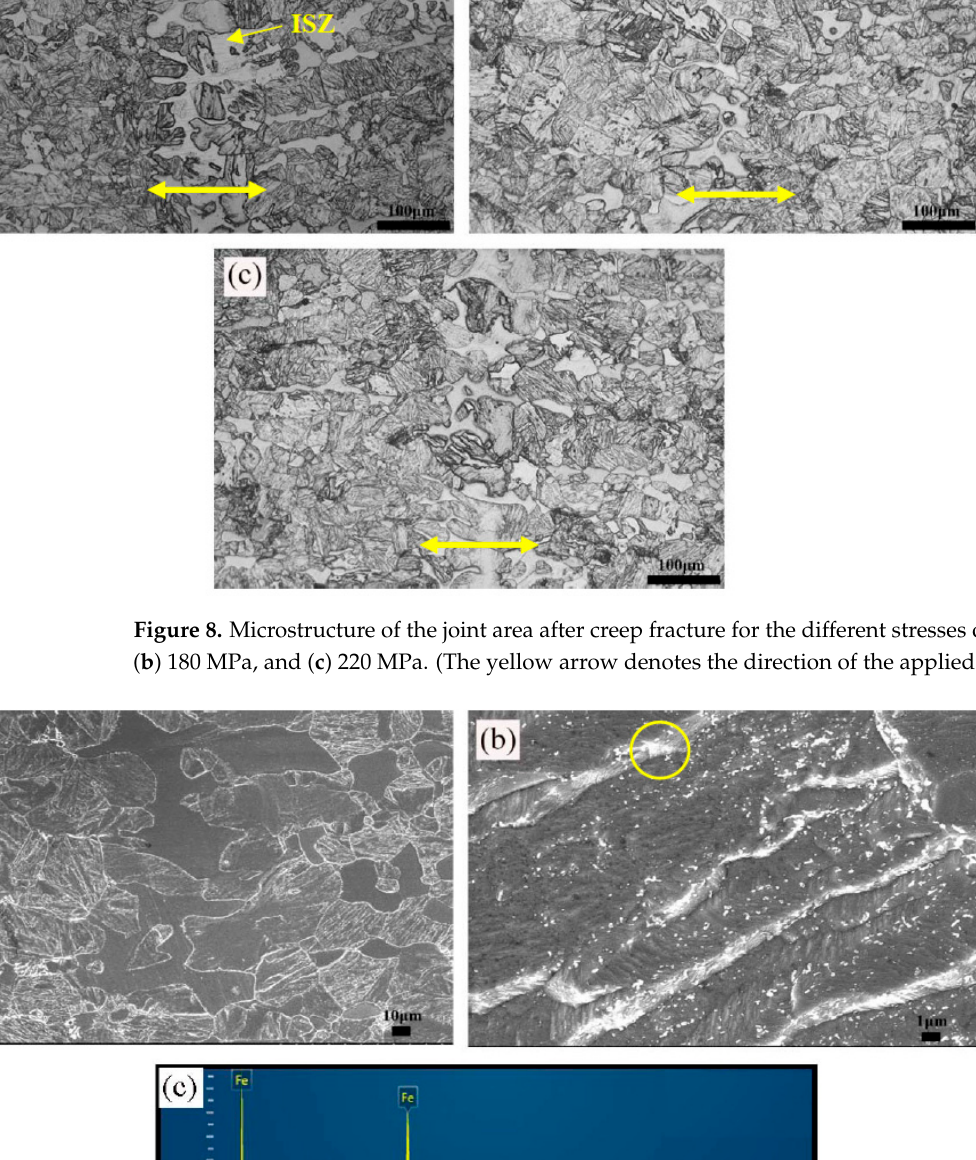
Figure 9. SEM images of the TLP joint after creep fracture under a stress of 220 MPa: ( a ) the low- magnification image, ( b ) the distribution of the M 23 C 6 carbides, and ( c ) the EDS analysis of the M 23 C 6 carbide indicated by circle in Fig. 9(b).